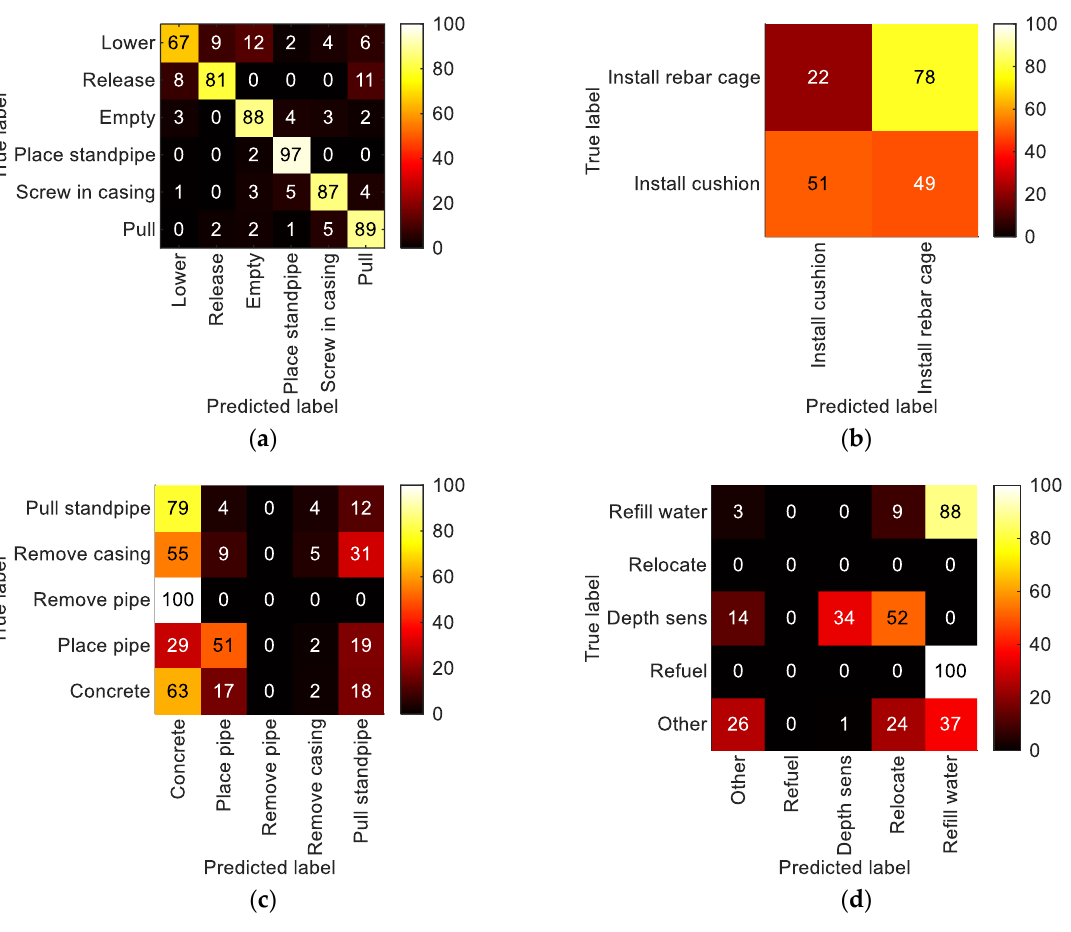
Figure 8. LoD3 confusion matrix for the DeepConvBiLSTM: ( a ) drill, ( b ) reinforce; ( c ) concrete; and ( d ) secondary processes.